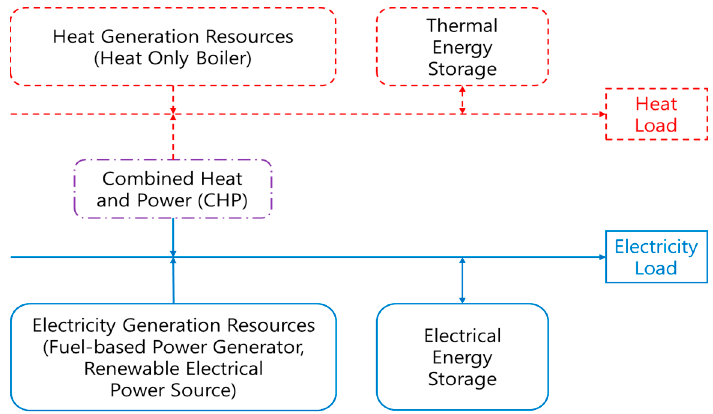
Figure 1. Model of the multi-energy system.